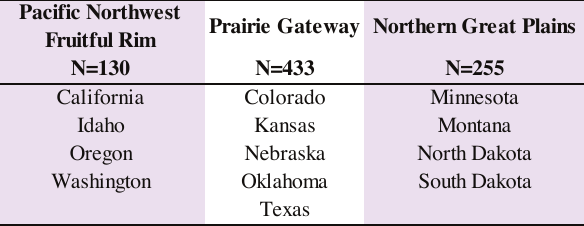
Table 1: States surveyed and their classification into